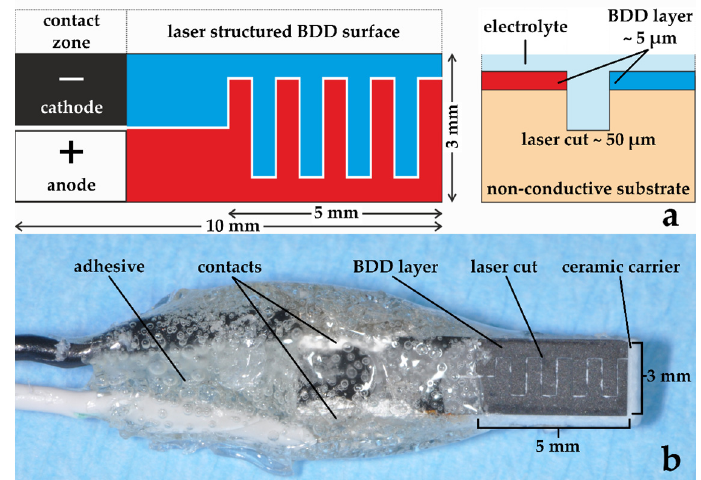
Figure 2. Ceramic double diamond electrode. The conductive boron-doped diamond (BDD) layer is added to a non-conductive carrier. The laser cut allows both electrodes to share the same carrier and reduces the gap between the anode and cathode. ( a ) Schematic representation, ( b ) prototype.